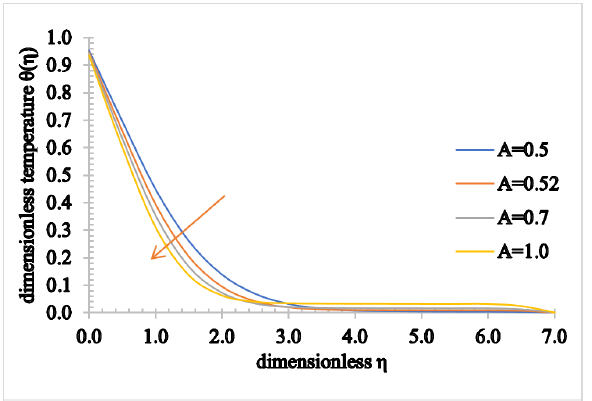
proportional to the thermal diffusivity, the thermal diffusion rate is reduced for higher estimated values of Pr. As a consequence, the temperature of the fluid is significantly reduced as well as the thermal boundary layer thickness. Con- versely, the nanoparticle volume fraction of the fluid and the